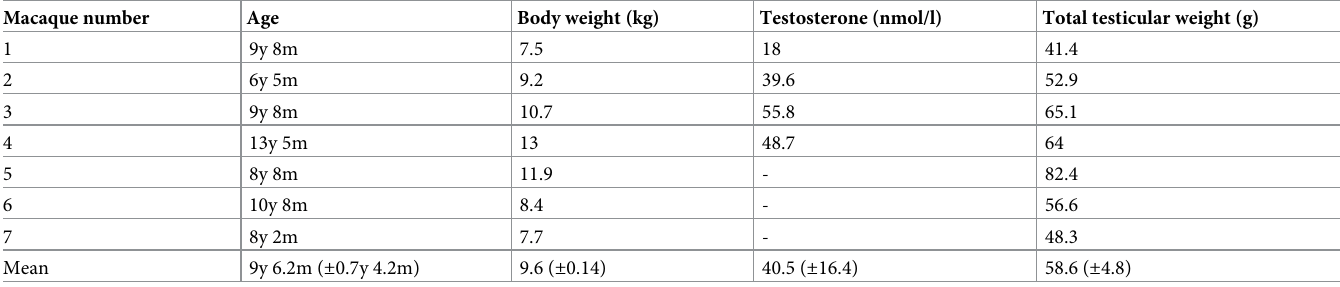
Table 1. Parameters of adult macaque testicular